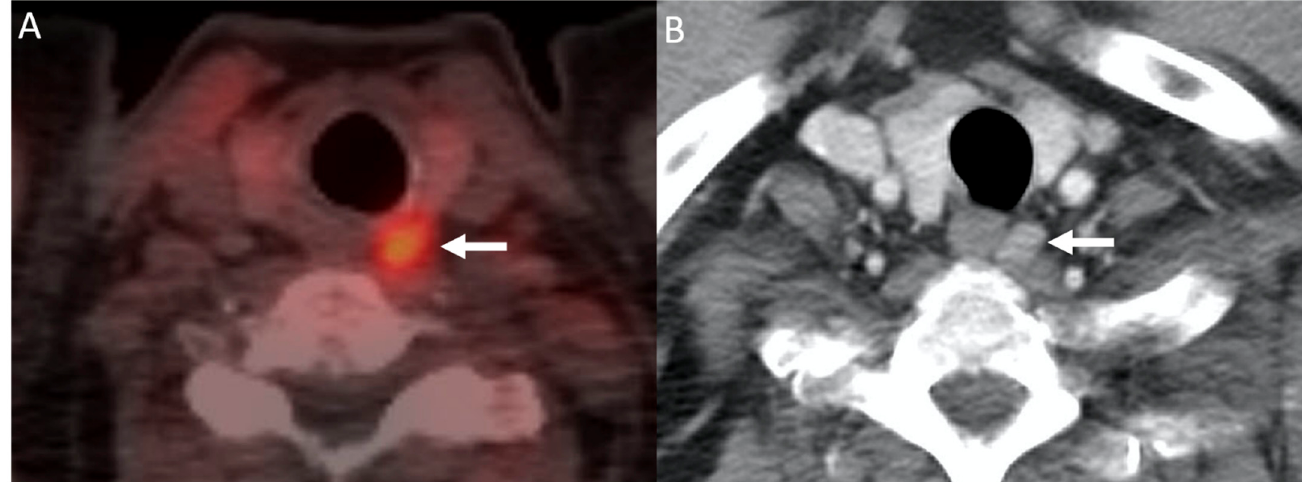
Figure 6. Choline PET/CT: 68-year-old man with hypercalcemia and history of prostate cancer. 11 C-Choline-PET/CT image ( A ) demonstrating focal choline uptake within a nodule posterior to the left mid thyroid gland (arrow). Subsequent contrast-enhanced CT ( B ) demonstrating a corresponding enhancing nodule. The patient was subsequently taken for surgical resection which revealed a left upper parathyroid